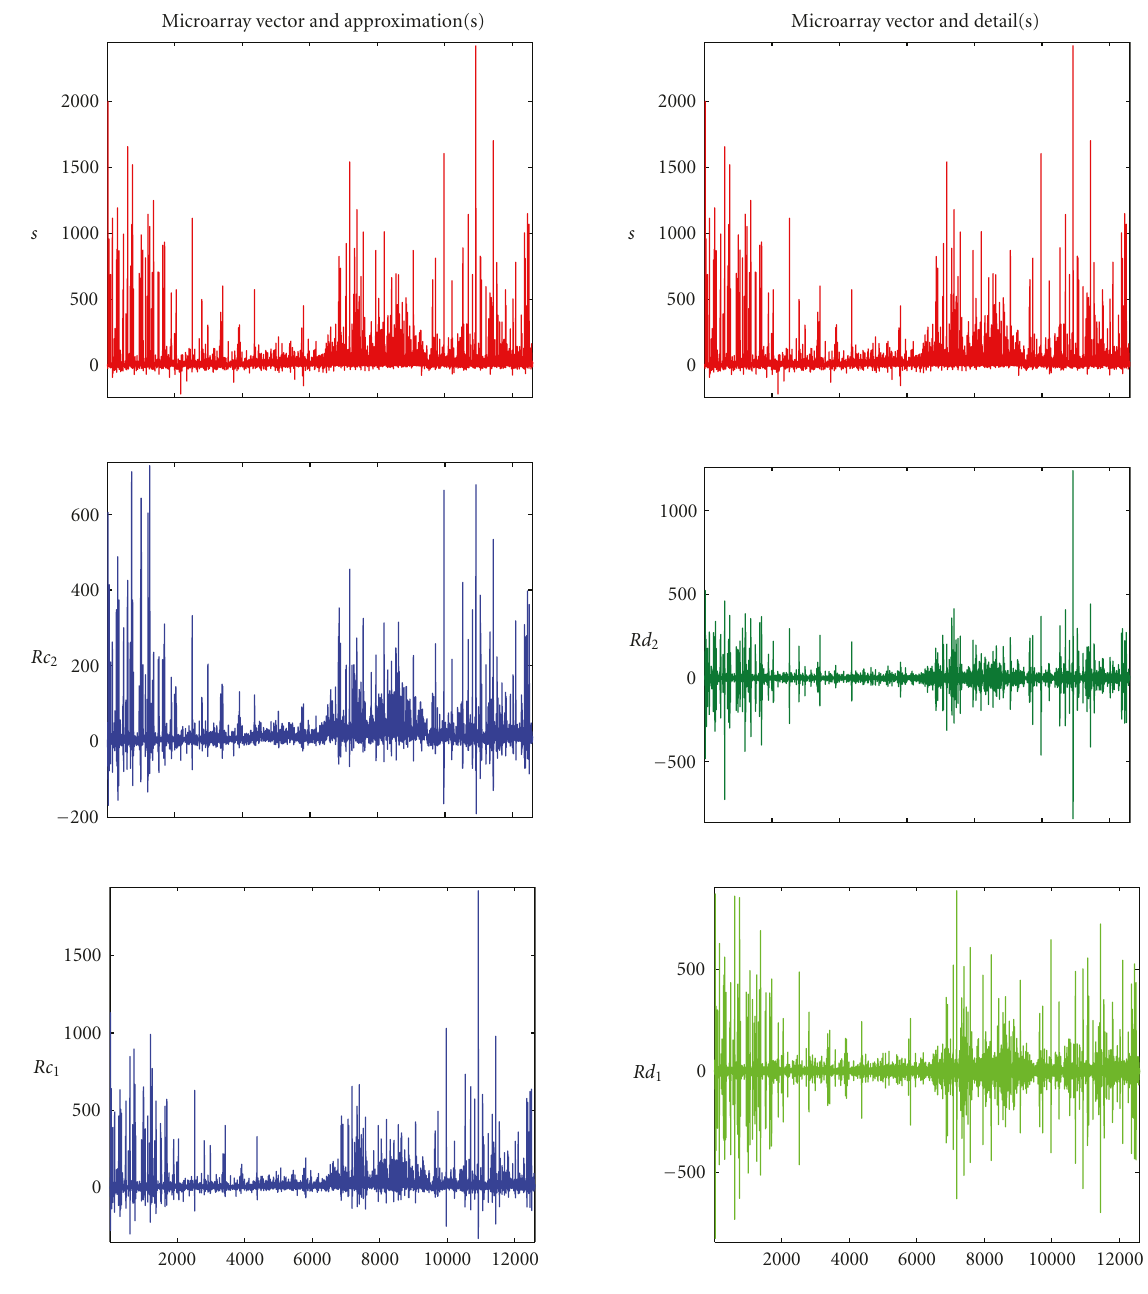
Figure 2: Approximations at 2 levels and details at 2